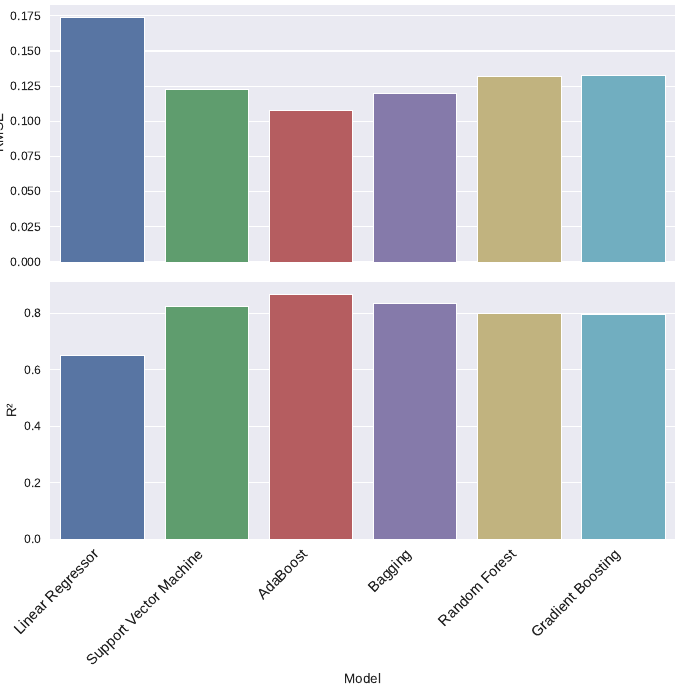
Figure 3. RMSE and R 2 estimations for different machine learning algorithms using the training data set.